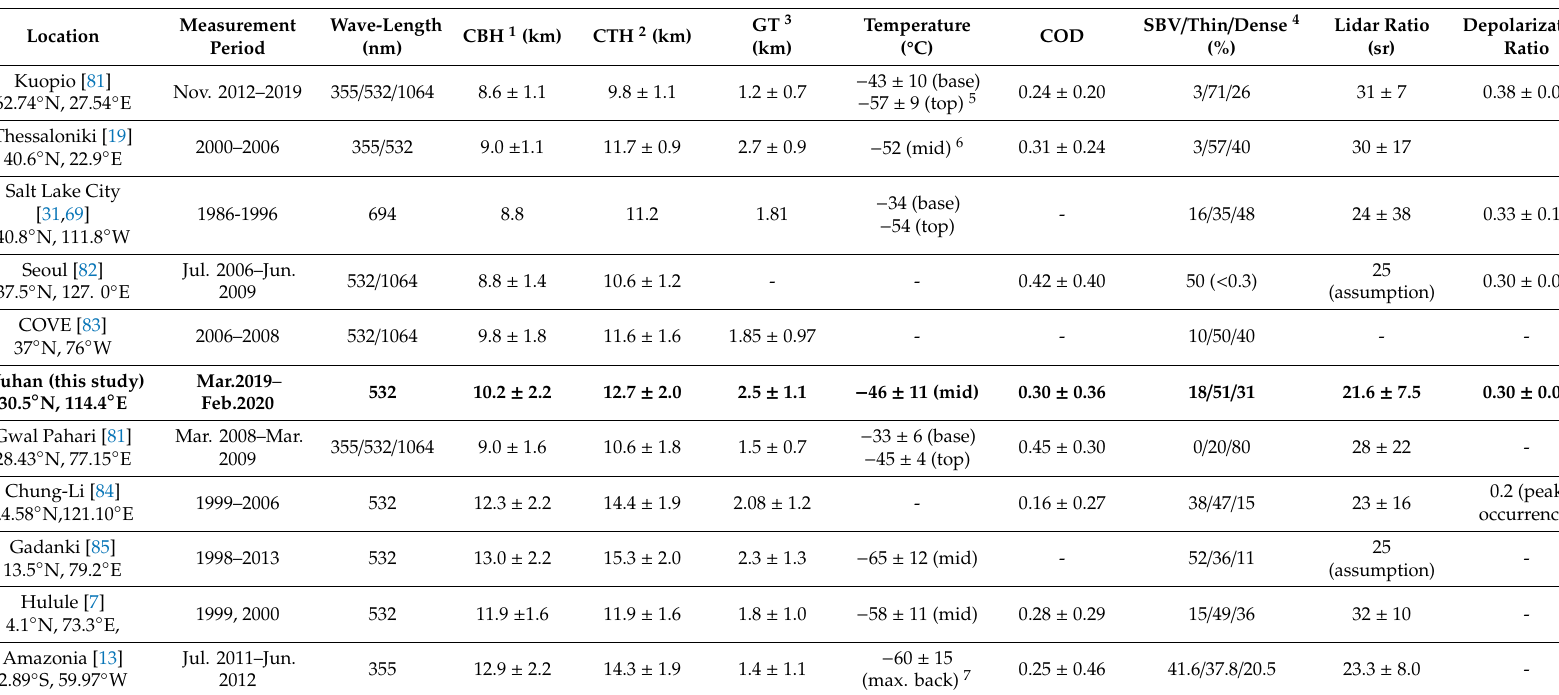
Table 3. Cirrus cloud statistical characteristics from long-term (at least a few months) ground-based lidar measurements at di ff erent locations around the world. Measurement Location